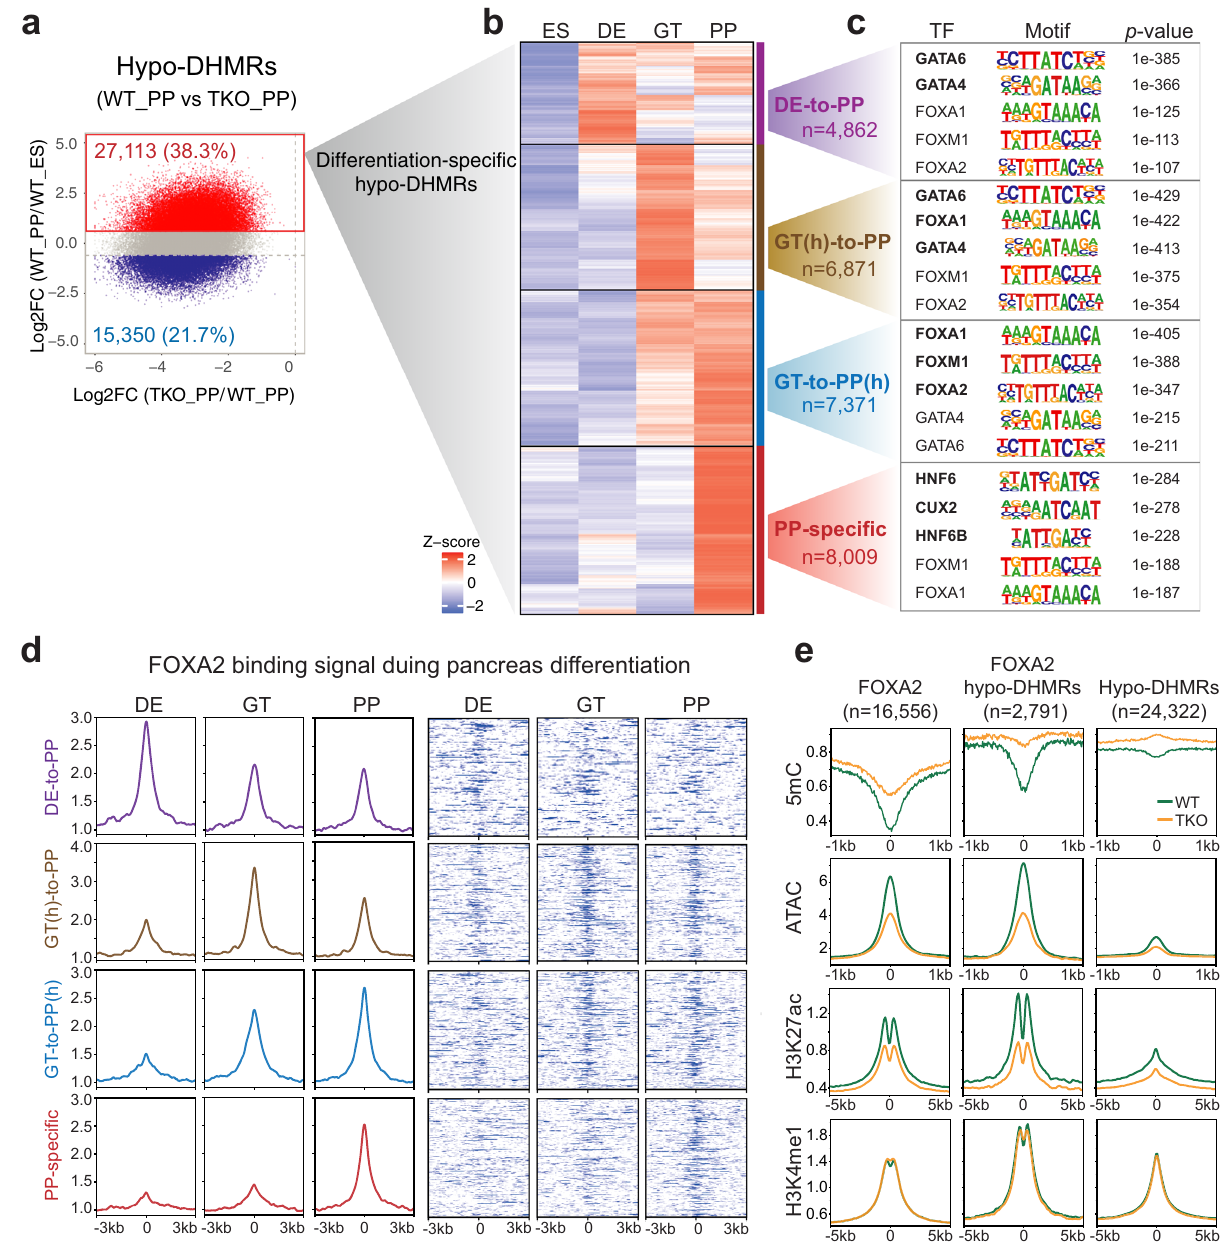
Fig. 3 Loss of TET disrupts epigenetic dynamics at differentiation-speci fi c hypo-DHMRs associated with distinct pioneer TFs motifs. a Scatterplot showing a log 2 -fold change of 5hmC in pancreatic progenitors (WT_PP) versus hESCs (WT_ES) within hypo-DHMRs identi fi ed in TKO_PP cells. Red indicates increased 5hmC and blue shows decreased 5hmC in pancreatic progenitors relative to hESCs (|fold change| ≥ 1.5, FDR < 0.05). b Clustering of 5hmC signals in WT cells at ES, DE, GT, and PP stage. Each row represents one hypo-DHMR showing an increased 5hmC in pancreatic progenitors compared with hESCs. Red represents high 5hmC; blue indicates low 5hmC. c Motif enrichment analysis among the four clusters de fi ned in b . The top fi ve known motifs are shown. The signi fi cance was statistically determined by ZOOPS scoring coupled with hypergeometric enrichment calculations without multiple test correction. d Average density plots and heatmaps showing dynamic changes of FOXA2 binding in DE, GT, and PP lineage intermediates across the four clusters de fi ned in b . The color scale from white to blue in heatmaps represents normalized FOXA2 signal from low to high. e Enrichment pro fi le of methylation ratio (5mC/C), chromatin accessibility (ATAC), H3K27ac, and H3K4me1 at FOXA2-binding sites alone (left column), ‘ differentiation-speci fi c hypo-DHMRs ’ alone (right column) and ‘ differentiation-speci fi c hypo-DHMRs ’ overlapped with FOXA2-binding sites (middle column). The WT signal is marked in green, and the TKO signal is in orange. active and open chromatin at FOXA2-increased sites in PP (Supplementary Fig. 4c). To comprehensively characterize (Supplementary Fig. 4c). Although DNA hypermethylation was temporal patterns of FOXA2 recruitment at the FOXA2- found in both groups upon TET depletion (Supplementary decreased sites, we clustered FOXA2 binding signal in WT cells Fig. 4d), H3K27ac, H3K4me1, and ATAC signals were signi fi - at the DE, GT, and PP stages. Three distinct patterns of FOXA2 cantly lost at the FOXA2-decreased but not -increased sites occupancy were observed. Cluster I regions (149) were bound by NATURE COMMUNICATIONS| (2022) 13:3907